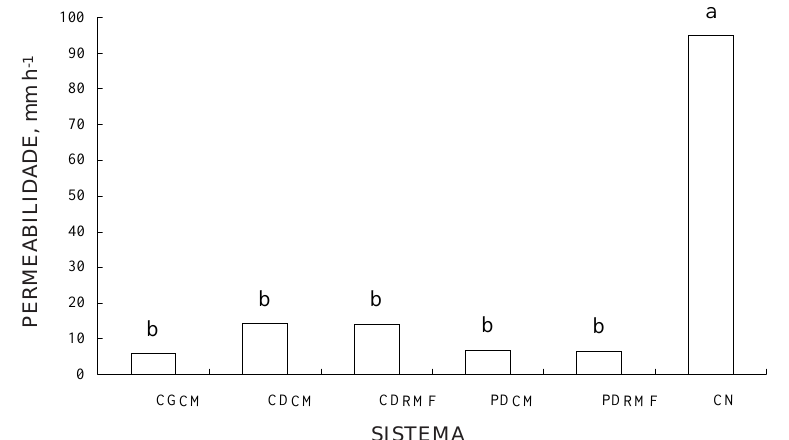
Figura 3. Permeabilidade do solo na profundidade de 15 cm em Latossolo Vermelho distrófico típico, em diferentes sistemas de manejo e cerrado nativo, Sete Lagoas